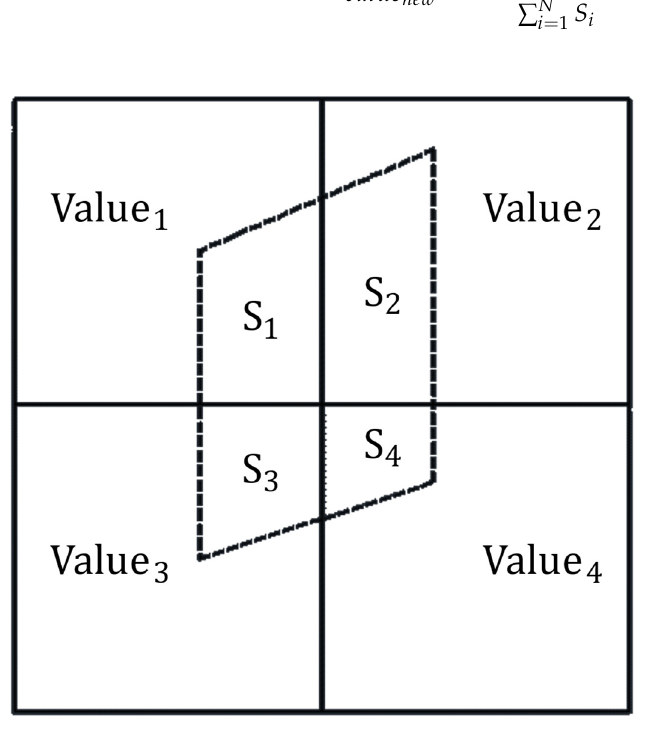
Figure 5. Principle of the 2D mesh mapping method.